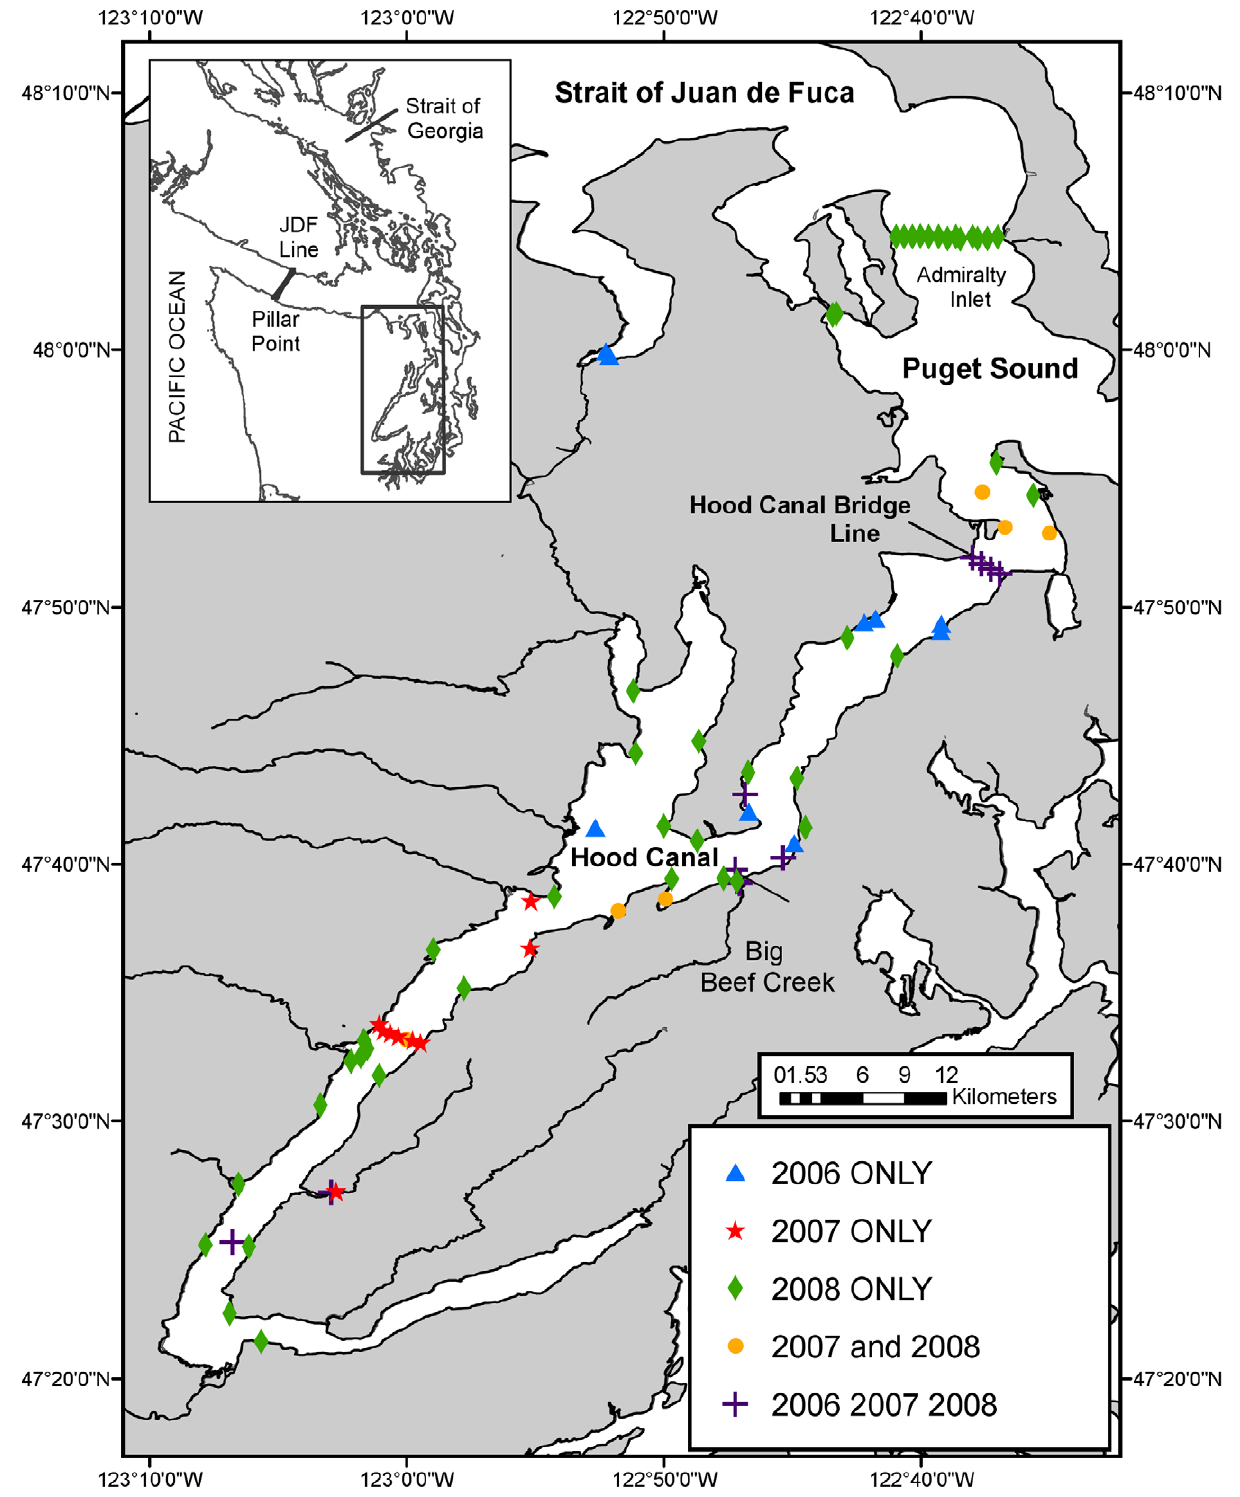
Figure 2. Locations of acoustic telemetry receivers in 2006, 2007, and 2008. In all three years, two receivers were placed at the river mouth to detect outmigrating smolts. The Hood Canal Bridge line was comprised of four receivers in 2006 and seven receivers in 2007 and 2008. A line of 31–33 receivers spanned the Strait of Juan de Fuca at Pillar Point in all three years, and a line of 13 receivers was deployed in Admiralty Inlet in 2008. Additional receivers were placed throughout Hood Canal and Puget Sound to observe movement patterns.